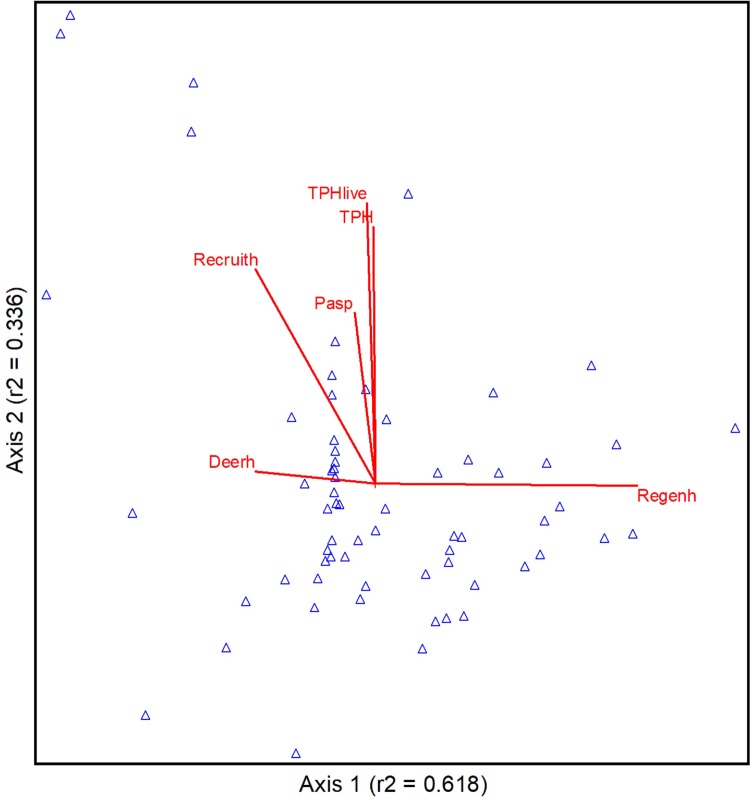
A joint plot depicts the results of nonmetric multidimensional scaling (NMS) ordination on a matrix of 65 plots by 16 monitoring variables.Highly correlated environmental variables (r2 ≥ 0.3) are overlaid on the ordination to show relationships to primary axes. Vectors indicate direction and strength (length) of these factors in the ordination space defined by plot values of all measured variables. Variables shown are: deer pellet groups ha-1 (Deerh), aspen recruitment stems ha-1 (Recruith), percent aspen cover (Pasp), live mature trees ha-1 (TPHlive), trees ha-1 (TPH), and aspen regeneration stems ha-1 (Regenh). Triangles show locations of plot scores in “data space” within the NMS ordination.